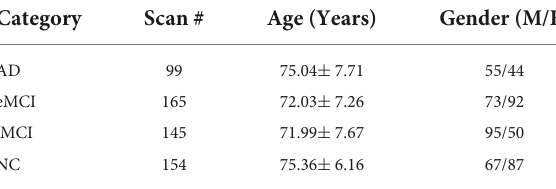
TABLE 1 Demographic information of the involved 563 rs-fMRI subjects from the Alzheimer’s Disease Neuroimaging Initiative (ADNI)